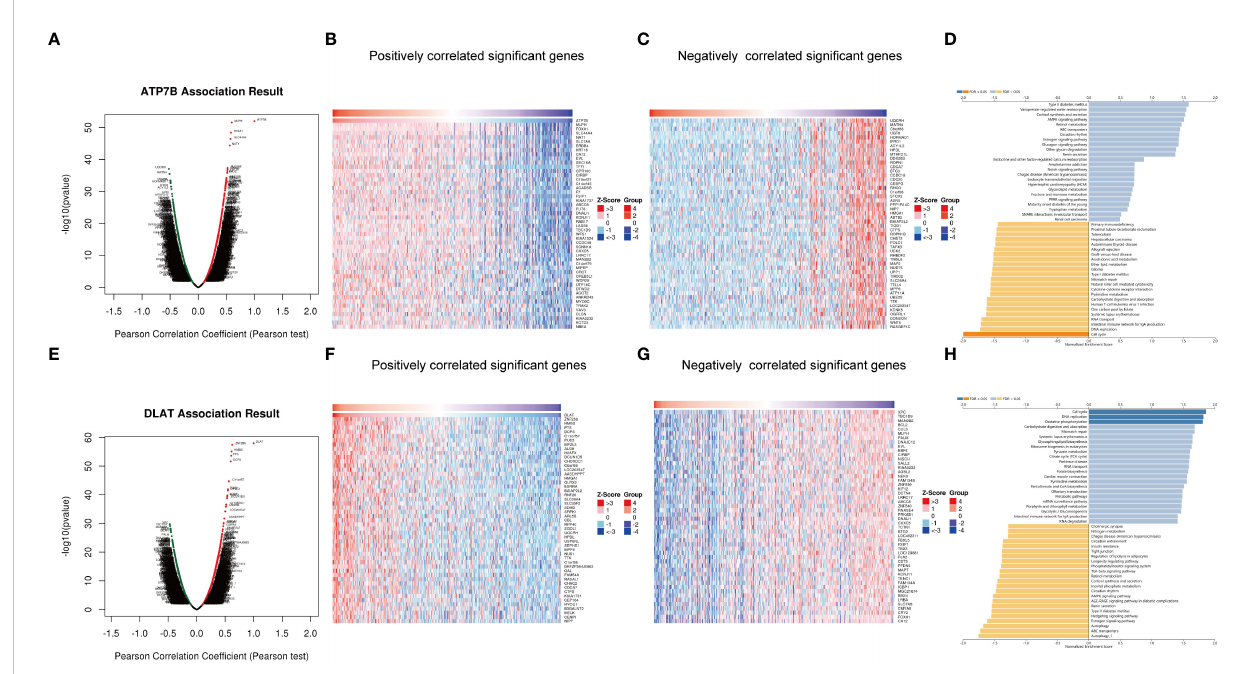
FIGURE 8 Genes co-expressed with ATP7B (A – D) and DLAT (E – H) in breast cancer. Volcano Plot showed genes associated with ATP7B (A) and DLAT (E) in breast cancer samples analyzed by LinkedOmics. Heatmap showed the positively correlated genes with ATP7B (B) and DLAT (F) and the negatively correlated genes with ATP7B (C) and DLAT (G) in breast cancer samples. The bar plot showed the GSEA results of genes associated with ATP7B (D) and DLAT (H)